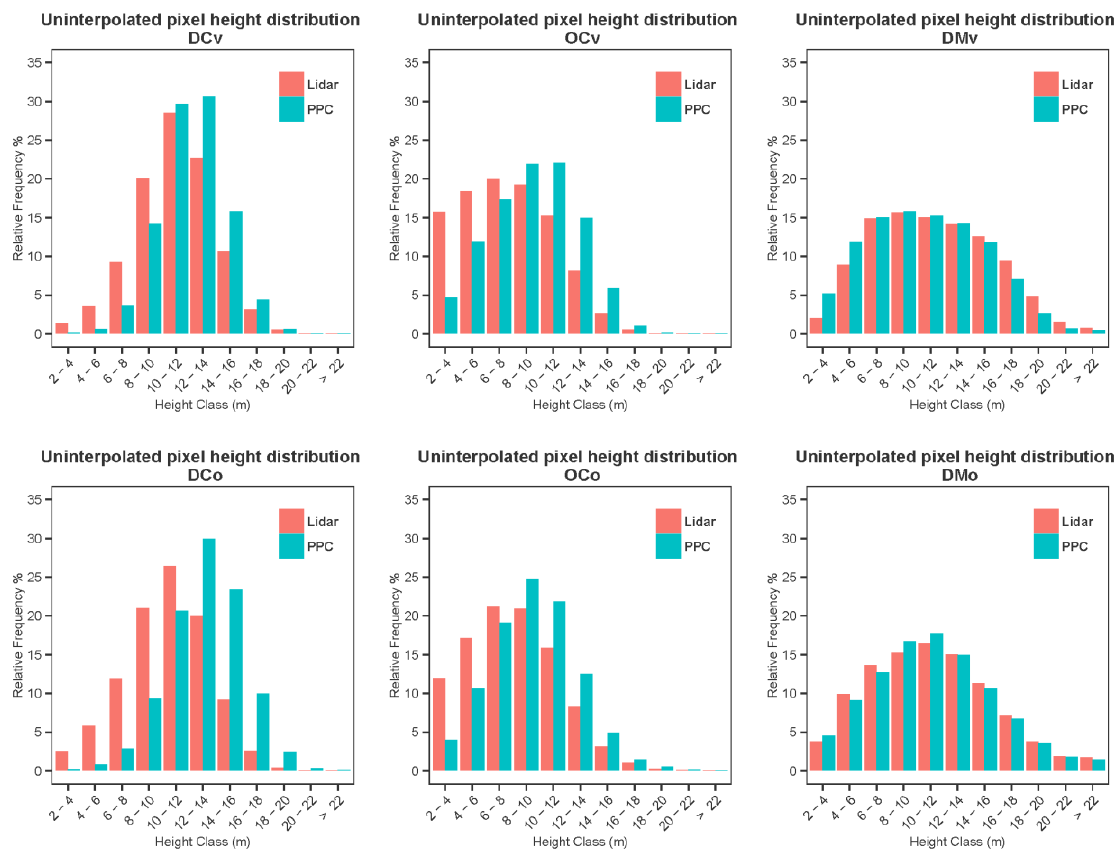
Figure 3. Relative point height distributions of lidar and photogrammetric points for corresponding locations of the uninterpolated canopy height models